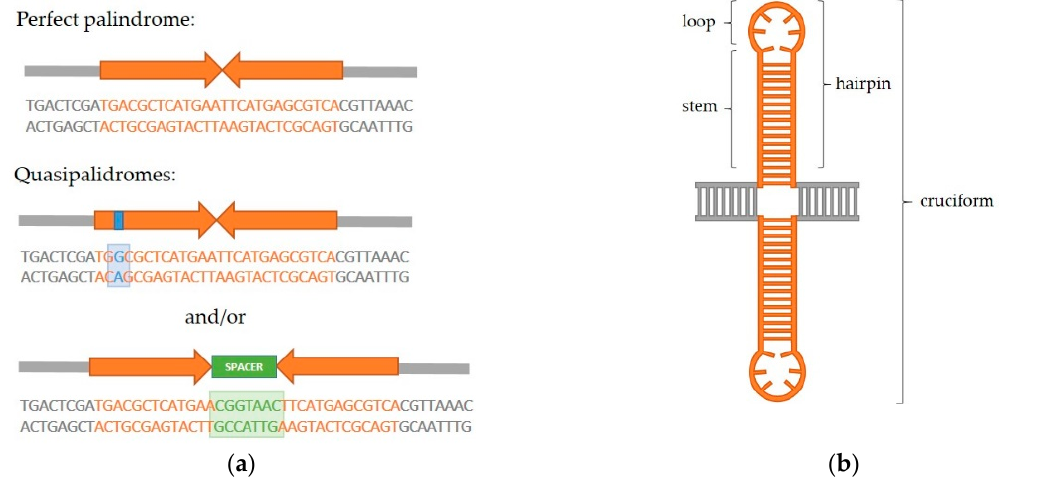
Figure 1. Palindromic sequences and secondary structures. ( a ) Types of palindromic sequences. A perfect palindrome consists of two identical inverted repeats adjacent to one another. A quasipalindrome can contain mismatches between the two inverted repeats and/or a central spacer region. ( b ) Palindromic sequences can form secondary structures due to intrastrand base pairing. In ssDNA, the hairpin structure, consisting of a stem and a loop, is formed. Two hairpins, one across from the other in a dsDNA, together constitute a cruciform structure.